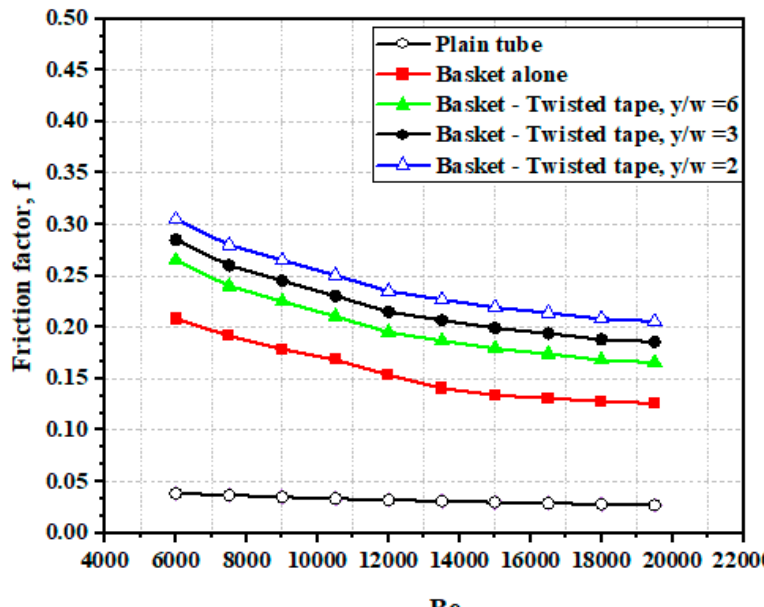
Figure 7. Difference of friction factor with and Reynolds number for heat exchanger trim by basket alone and combined basket–twisted tape inserts.